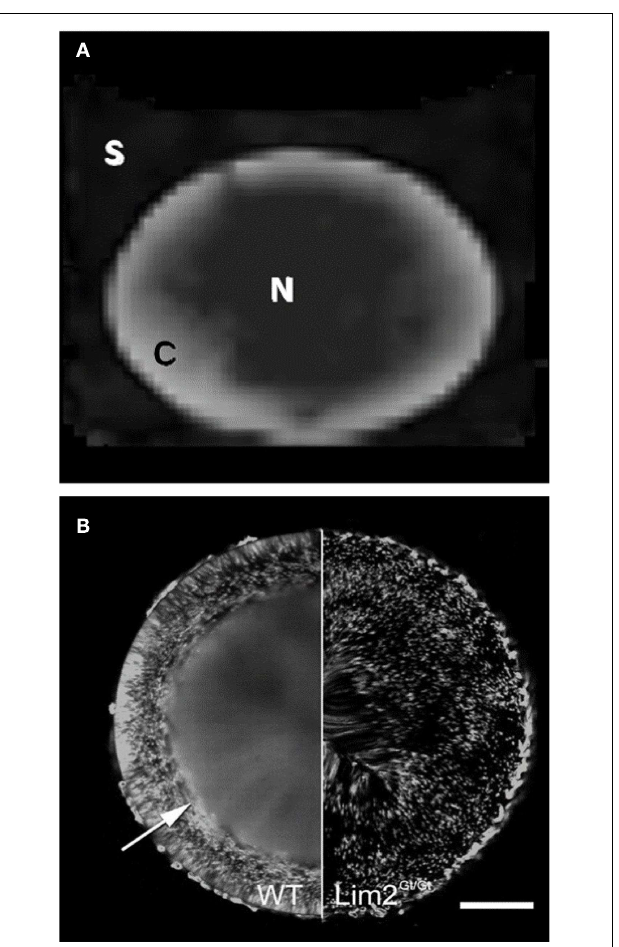
FIGURE 10 | Comparison of FA map with pattern of large molecule diffusion in the mouse lens. (A) The FA map of the bovine lens from Figure 9D , showing anisotropy in the cortex and relative isotropy in the core. (B) Green fluorescent protein (GFP) expression in an otherwise normal (WT) mouse lens; and in a mouse lens deficient for the Lim2 protein (Lim2 Gt/Gt ), which is required in the formation of the large molecule diffusion pathway (LMDP; reproduced with permission from Shi et al. (2009). In the normal mouse lens the establishment of the LMDP allows GFP, made by scattered fiber cells, to diffuse evenly in the inner lens, in fibers located 100–200 µ m below the lens surface (arrow) . In the Lim2-deficient lens the LMDP cannot form and GFP in the inner lens does not diffuse: it remains scattered in the cells that synthesize it. Scale bar, 250 µ